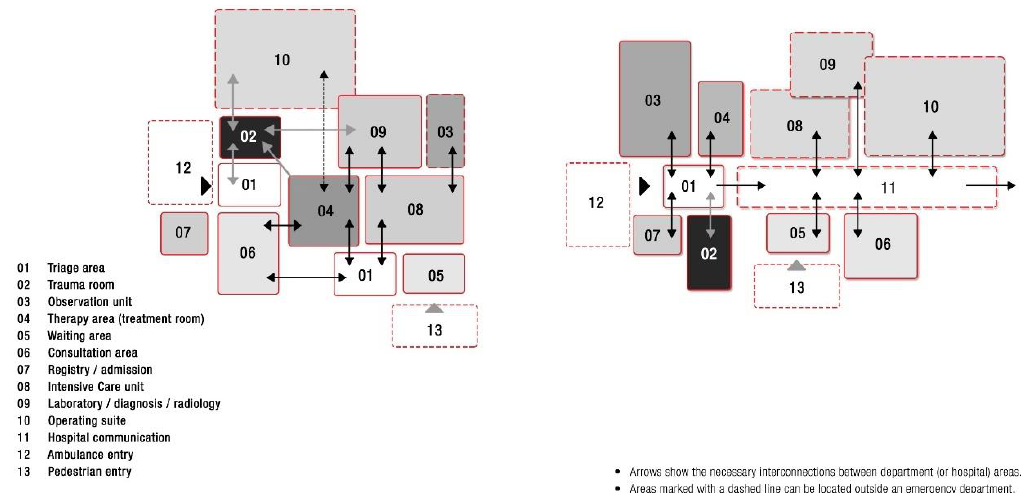
Figure 5. Schemes for the FSED (left) and Hospital ED (right) model for the Emergency Department, redrawn from [29]. Arrows show the necessary interconnection between department/hospital area; areas marked with dashed lines can be located outside the boundary of the emergency department area.